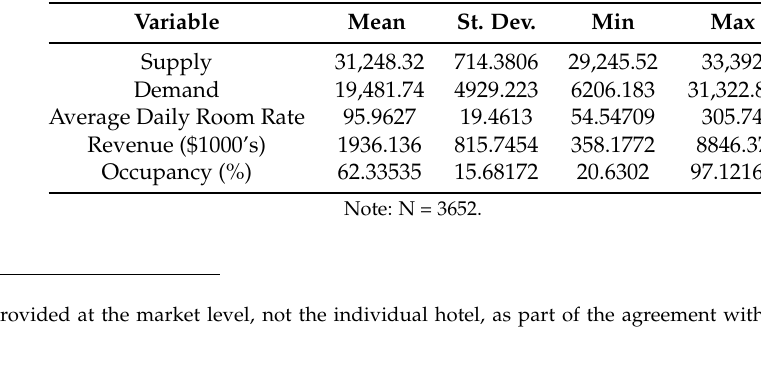
Table 2. Summary statistics, full